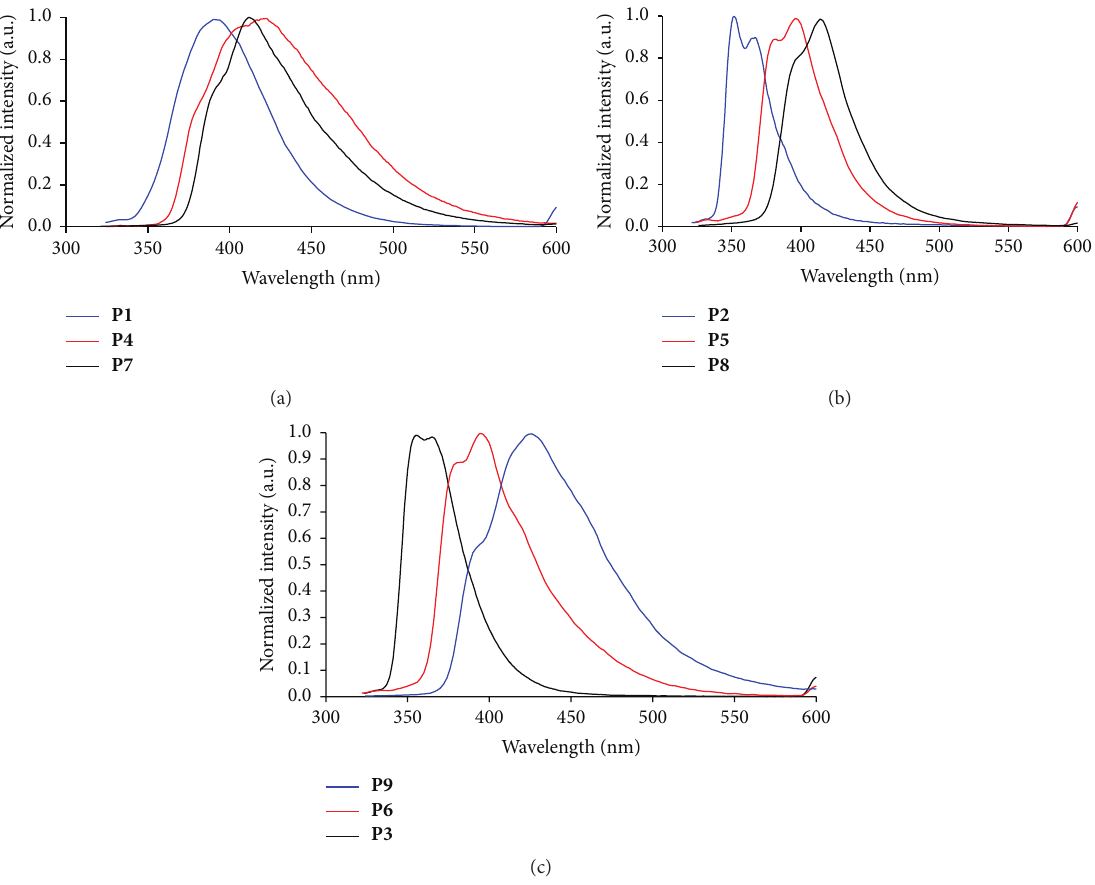
to self-assemble to achieve long-range order. An